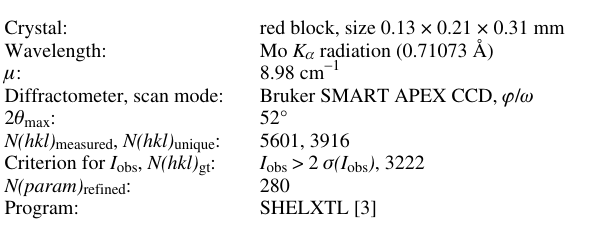
Table 1. Data collection and handling.